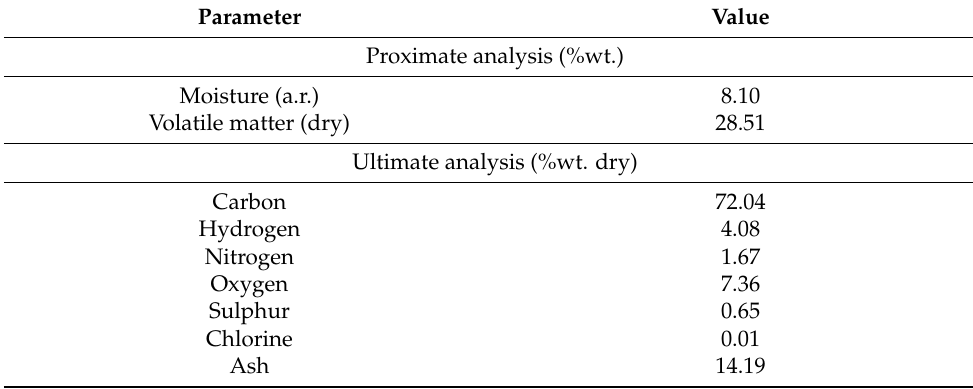
Table 2. Coal composition and thermal properties.